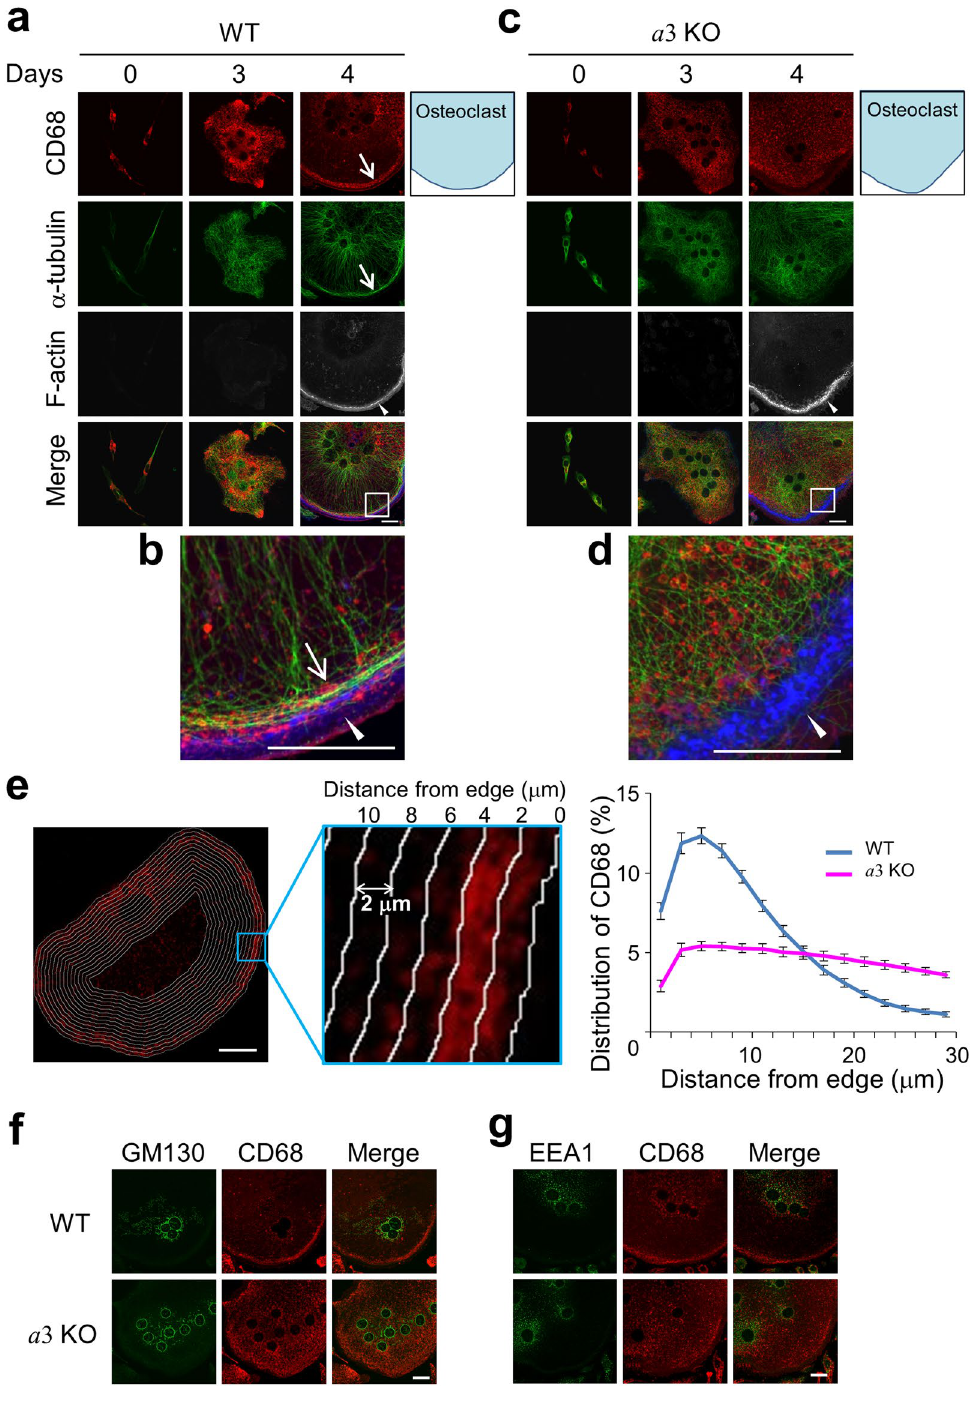
Figure 3. Localisations of organelles in osteoclasts differentiated from splenic macrophages. ( a – d ) Localisation of CD68 during differentiation. Macrophages from wild-type ( a , b ) and a 3-knockout ( c , d ) mice were obtained as adherent splenic cells after incubation with macrophage colony-stimulating factor for 3 days, and then cultured in medium containing RANKL for 4 days to induce differentiation. The cells were then fixed and stained for CD68 (red) and α -tubulin (green). F-actin was visualised with phalloidin (white). F-actin labelling is shown in blue in the merged images. Merged images of CD68, α -tubulin and F-actin from day 4 were magnified ( b , d ). Schematic illustrations of osteoclasts (day 4) are also shown (blue). Arrows indicate CD68 and α -tubulin at the periphery of wild-type osteoclasts. Arrowheads indicate actin rings. The images are representative of at least 30 cells. Bars indicate 20 μ m. ( e ) Distribution of CD68 in osteoclasts. An image of a cell differentiated as described in ( a – d ) was divided into 16 sections using the shape of the cell outline (left and middle panels). The width of each section was 2 μ m. The intensity of CD68 staining in each section was quantified, and the relative intensity was plotted against the distance from the edge of the cell (right panel). Blue and magenta